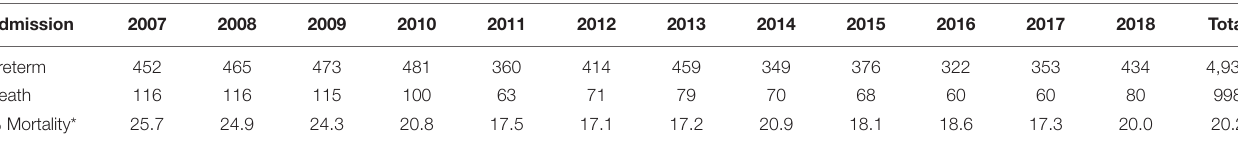
TABLE 3 | Preterm babies’ admissions and mortality